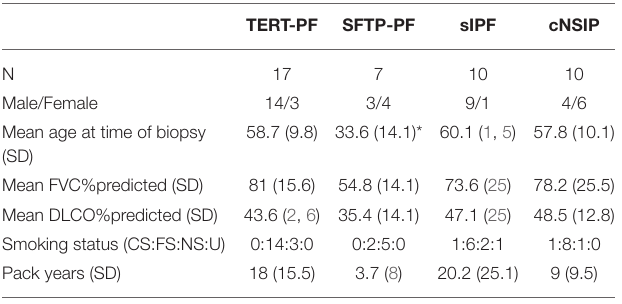
TABLE 1 | Baseline characteristics of study